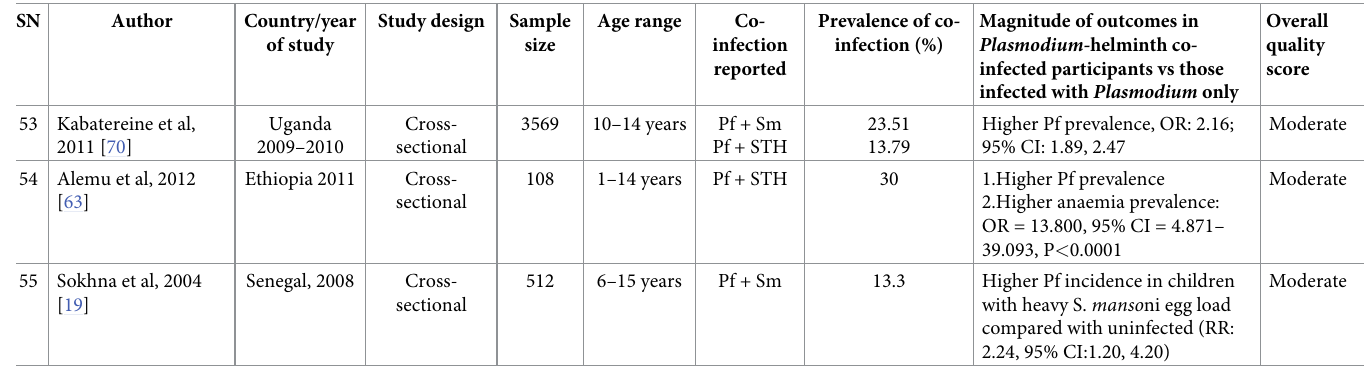
Prevalence of Plasmodium -helminth co-infections Overall, the pooled analysis showed that the prevalence of Plasmodium -STH co-infections in 22,114 children enrolled in 28 studies evaluating both groups of infection, in 13 countries across Central, East, West and Southern Africa, Southeast Asia and South America was 17.7% (95% CI 12.7–23.2%) (Fig 2). There was statistical heterogeneity (I 2 : 98.7%), suggesting a high level of heterogeneity among the included studies, although Egger’s regression test did not reach statistical significance (Egger’s test = 1.5039, p-value = 0.1388) (Fig 3). In a subgroup analysis, the pooled estimates showed that South America had the highest prevalence of 76.3% of co-infections, followed by Southern Africa (30.7%), West Africa (25.4%), East Africa (16.3%), Central Africa (13.1%) and South-east Asia (7.1%) (S1 Fig). Disaggregated by hel- minth types, the pooled prevalence of Plasmodium-Schistosoma co-infections in 9,803 children was 19.2% (95% CI: 9.6–31.1%); and the pooled prevalence of Plasmodium -STH co-infections in 12311 children was 17% (95%CI: 11.4–23.4%); (95% CI: 9.6–31.1%) (Fig 2). In a subgroup analysis of 12 studies reporting co-infection of Plasmodium and individual STH types in 6325 children, the prevalence for P . falciparum-A . lumbricoides co-infection was 24% (95% CI: 11.3– 39.6%), P . falciparum -hookworm 12.8% (95% CI: 4.8–23.9%) and P . falciparum-T . trichuria 9.9% (95% CI: 2.6–21.4%) (S2A, S2B and S2C Fig, respectively). For Plasmodium falciparum-S . haematobium co-infection, the pooled prevalence was 24.4% (95% CI: 11.9–39.6%) and 6.7% (95% CI: 1.8–14.6%) for Plasmodium falciparum-S . mansoni co-infection (S3A and S3B Fig, respectively). The funnel plot generated using the cases of Plasmodium -helminth co-infections compared with children infected with Plasmodium mono-infection and the standard error estimates of the prevalence was asymmetric, in keeping with the high level of heterogeneity between the included studies, but as indicated above, the Egger’s regression test was not statis- tically significant (Egger’s test = 1.5039, p-value = 0.1388) (Fig 3). Interactions of Plasmodium and helminths during co-infection Given a very high level of heterogeneity between the studies, random-effects models were used to calculate the summary odds ratio in this meta-analysis. The overall estimates on 24 studies showed lower odds of asymptomatic/uncomplicated or severe P . falciparum infection in chil- dren co-infected with STH when compared with those with Plasmodium only (summary